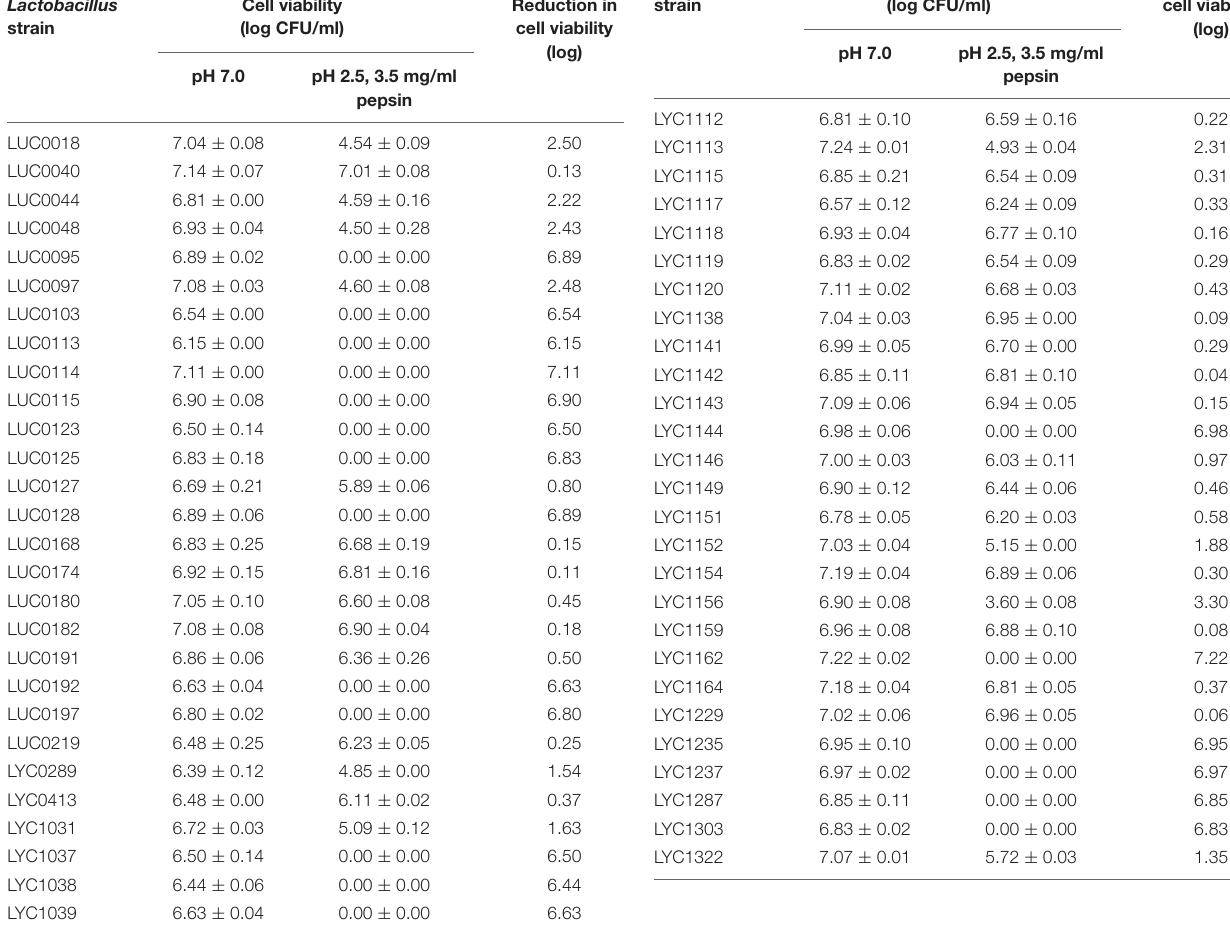
Cell viability (log